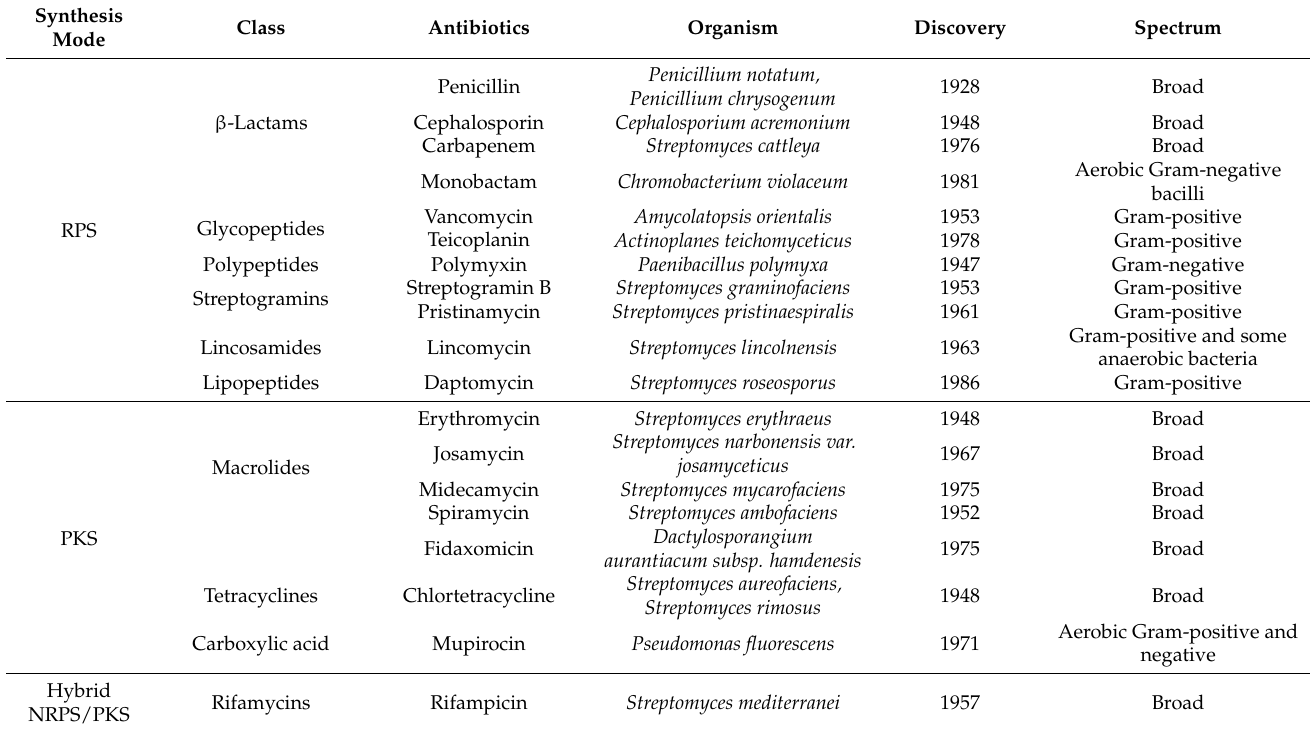
Table 1. Nonribosomal peptide (NRP) and polyketide (PK) molecules used currently in human medicine. Synthesis